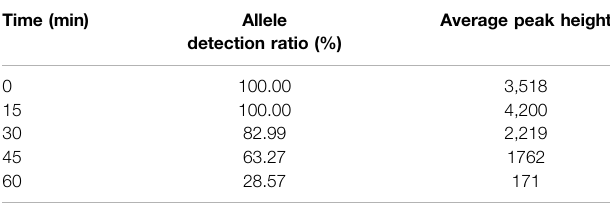
TABLE 1 | Allele detection ratio and average peak height of 27 loci of the 9948 DNA sample exposed at different time periods of ultraviolet. Time (min) Allele detection ratio (%)